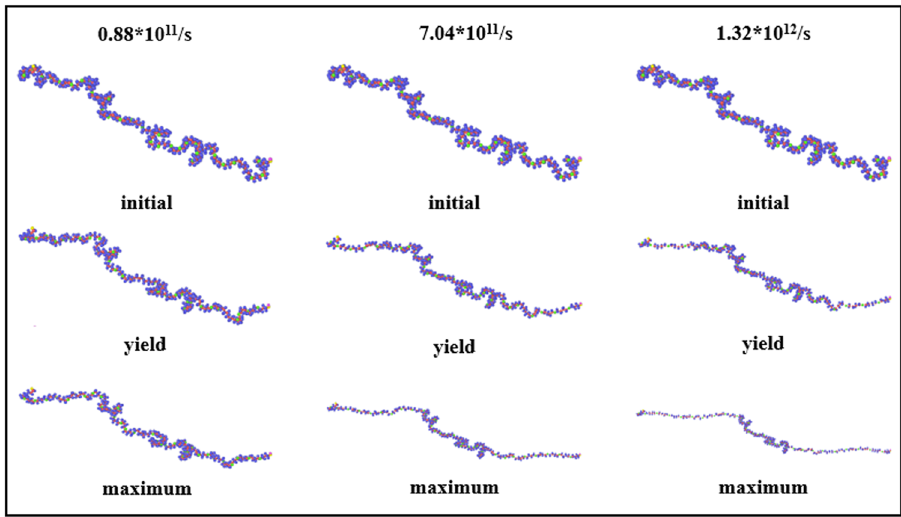
Figure 7: Con fi gurations of molecular chain at the initial, yield stress and maximum stress points at di ff erent strain rates of 0.88 × 10 11 , 7.04 × 10 11 and 1.32 × 10 12 /s,